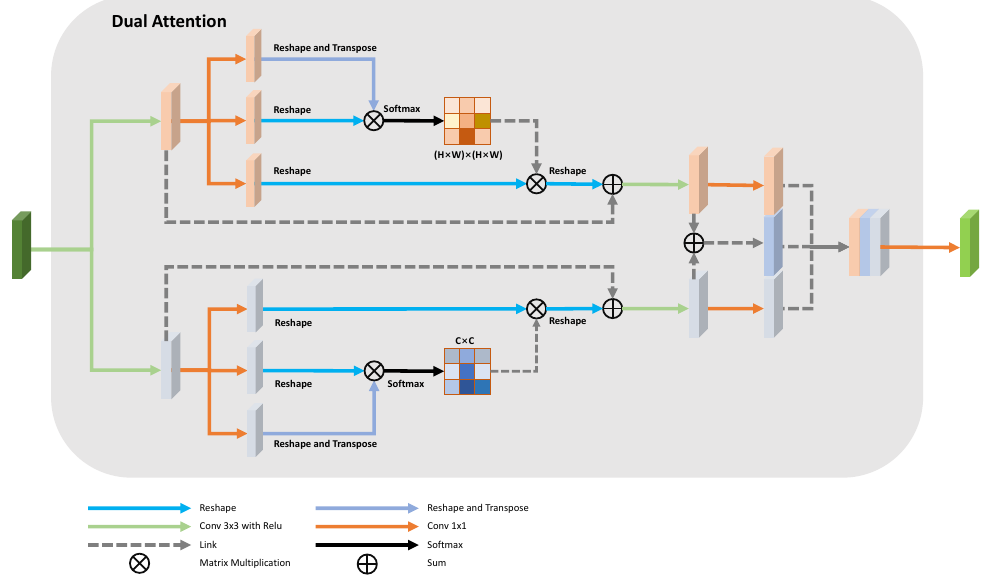
Figure 2. The proposed dual attention